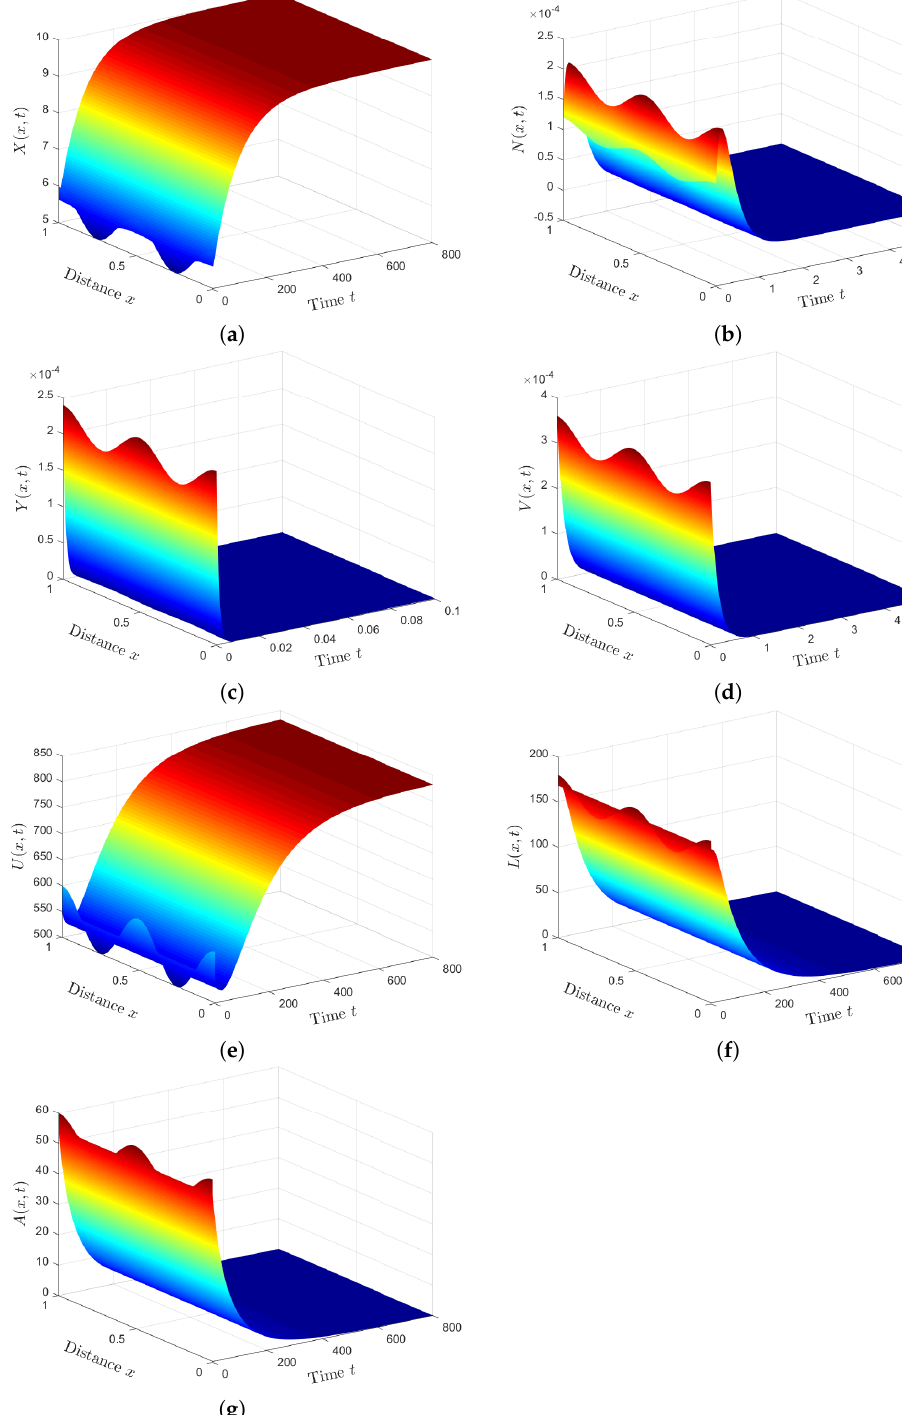
Figure 1. Numerical solution of PDEs (12)–(18) with initial condition (47) and boundary condition (48) in Plan (I). ( a ) Healthy ECs. ( b ) Latent infected ECs. ( c ) Active infected ECs. ( d ) SARS-CoV-2. ( e ) Healthy T cells. ( f Latent infected T cells. ( g ) Active infected T cells. Plan (II) (stability of Ξ 1 ) : We take ( σ , ξ , β V , τ ) = ( 0.5, 1.5, 6, 0.0025 ) . So, we obtain R 1 = 6.7641 > 1 and R 4 = 0.0011 < 1. Lemma 2 and Theorem 2 show the existence